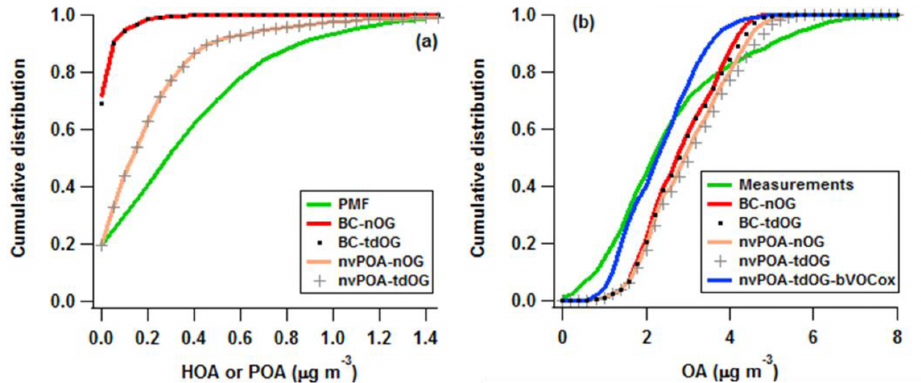
Figure 9. Cumulative distribution of HOA or POA (a) and OA (b) based on measurements and various simulation scenarios.